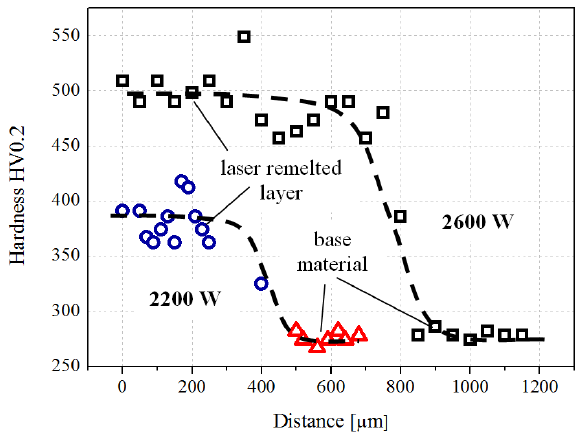
Figure 7. Hardness difference between the surface layer and the base materials (for 2200 W pulse power) and hardness profile across the interface (for 2600 W pulse power).